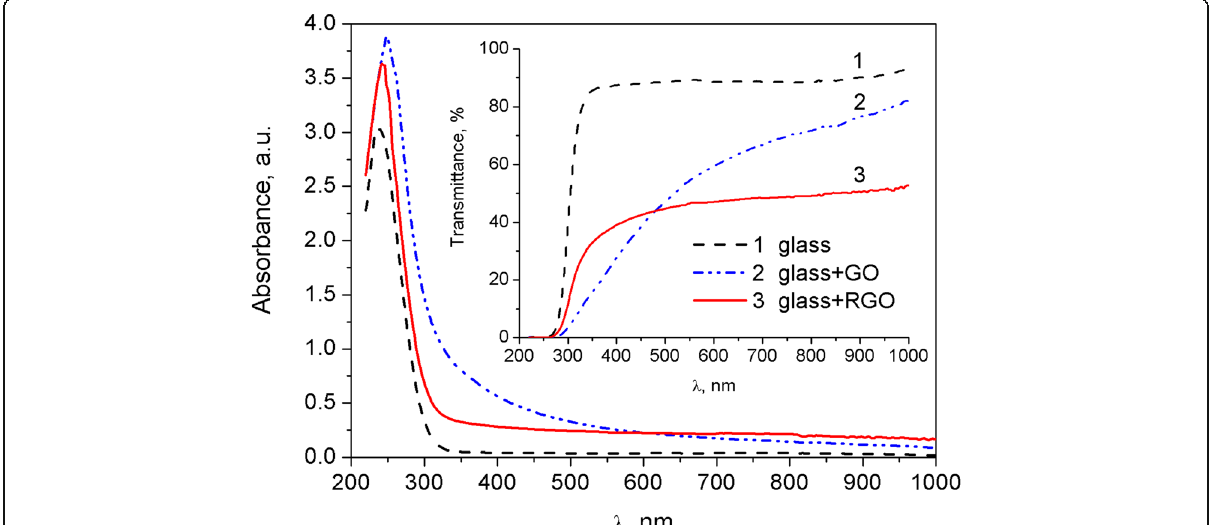
Fig. 3 UV – vis absorbance and transmittance spectra of the glass substrate (curve 1 ), films of GO (curve 2 ), and RGO (curve 3 ) on the glass